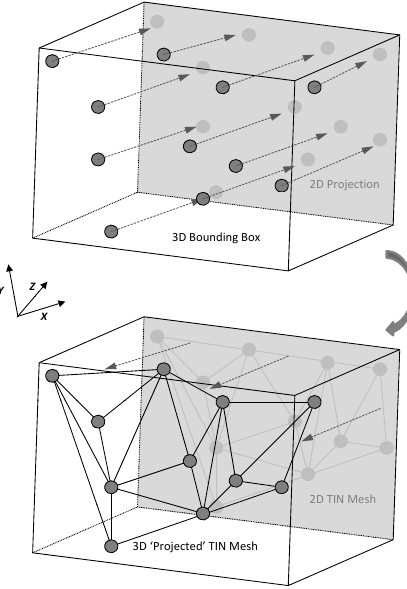
Figure 2: Schematic explanation of 3D ’projected’ TIN mesh